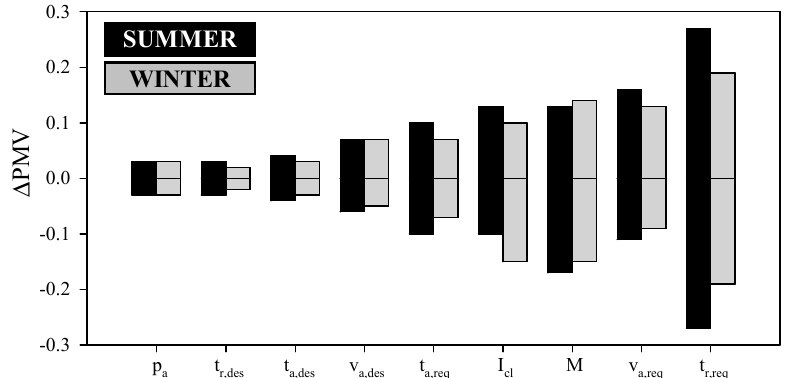
Figure 1. PMV sensitivity ( ∆ PMV) to the accuracy of each quantity required for the thermal environment assessment according to ISO 7730 Standard [9] under thermal neutrality conditions (PMV = 0). M = 1.2 met [20]. “req” and “des” subscripts are referred to the required and desired accuracy levels prescribed by ISO Standard 7726 [23]. Table 2. The classification proposed by ISO 7730 [9] and EN 16798-1 [11] Standards.